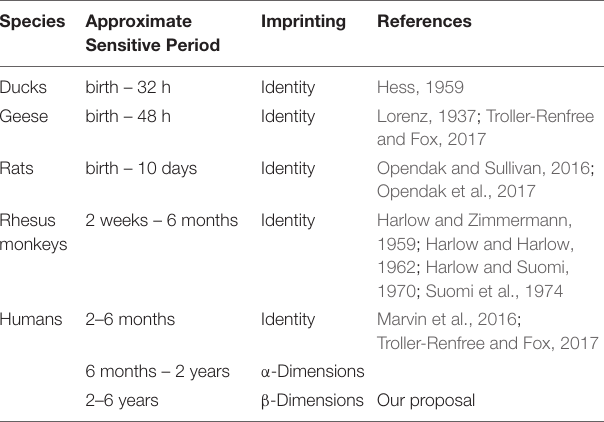
TABLE 6 | Sensitive periods in different